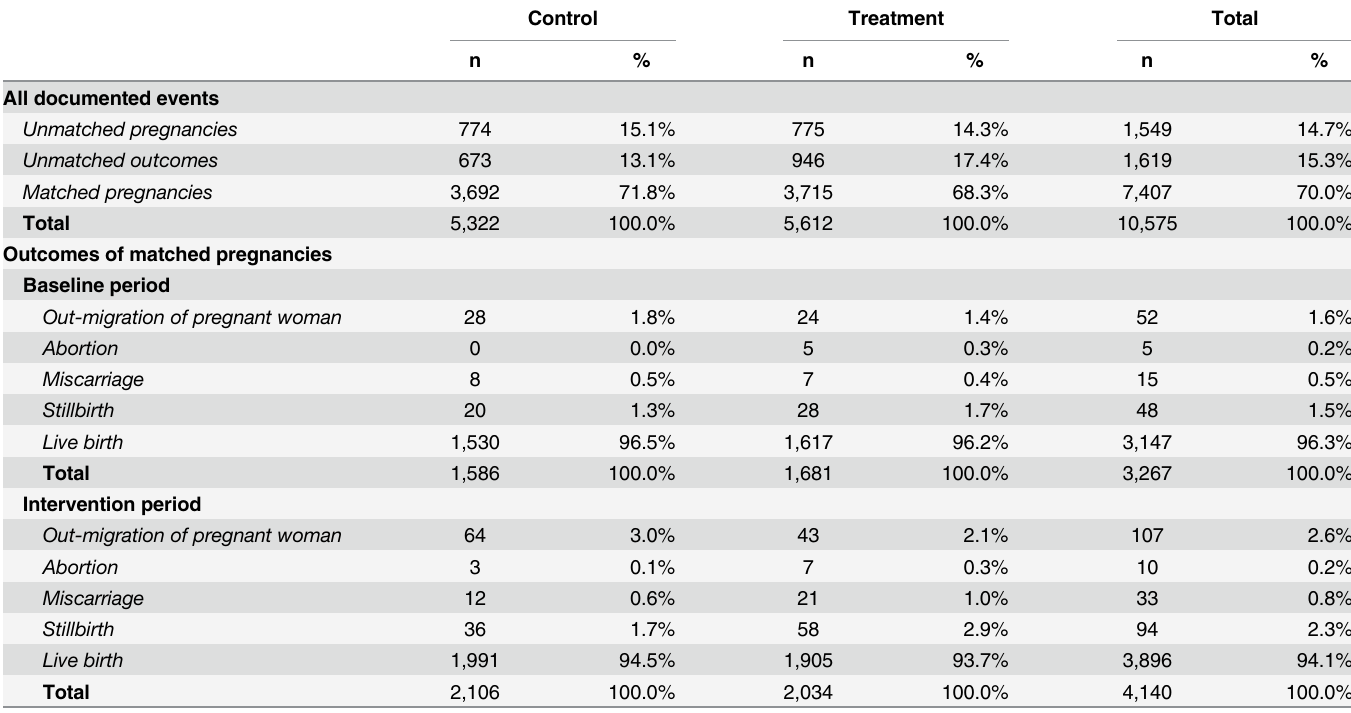
Table 3. Matching results by intervention periods and groups.